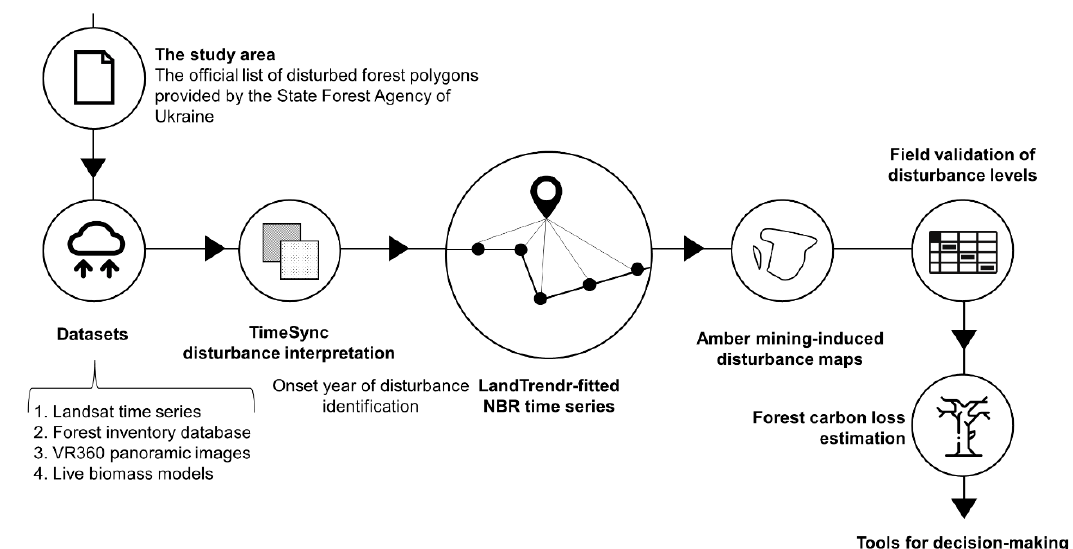
Figure 2. Overall workflow for processing the LTS to retrieve the history of amber disturbances and to calculate the carbon loss.